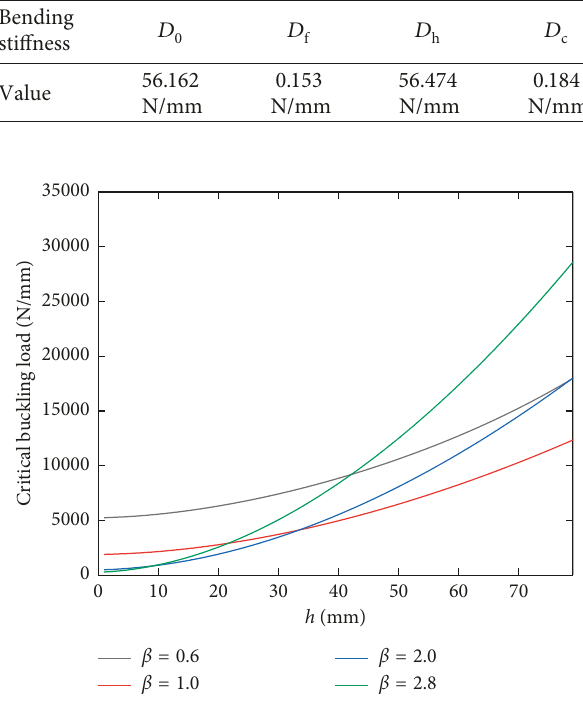
Figure 5: Relation between critical buckling load and core thickness for different β .